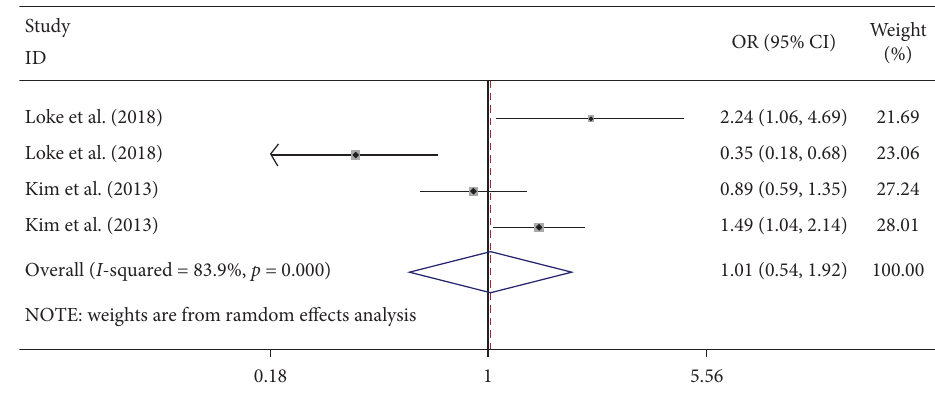
Figure 3: Forest plot showing the association between MS and the risk of decreased Table 4: Subgroup analyses for comparing nonosteoporosis to osteoporosis with or without MS. Group